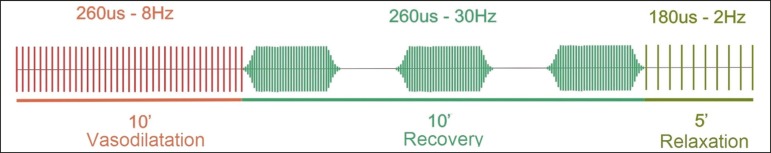
Three-phase EMS protocol.